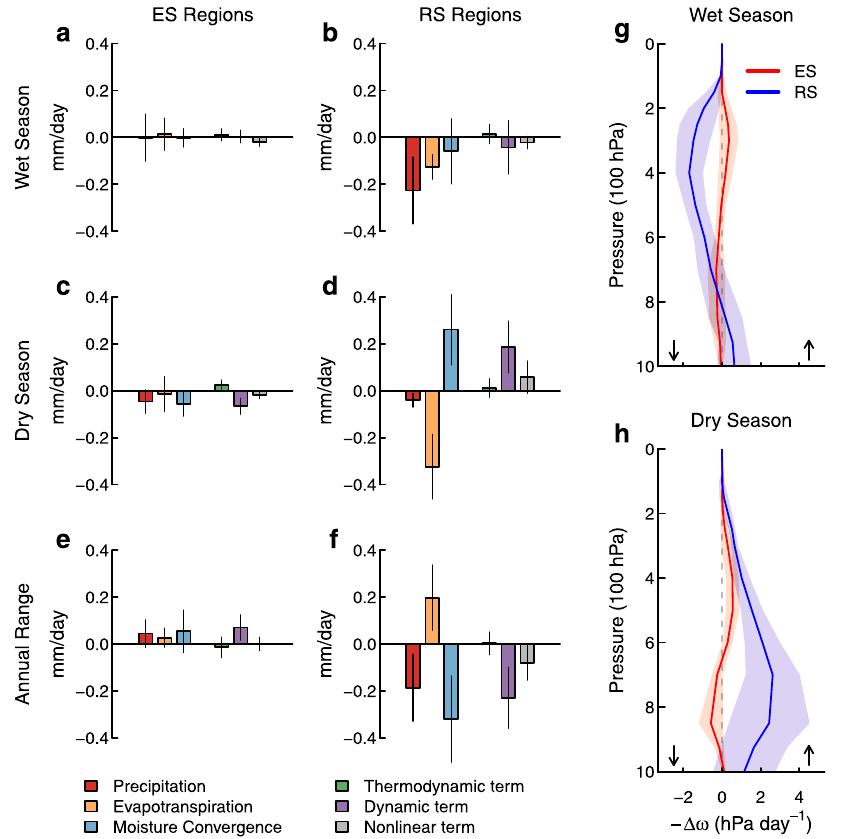
Fig. 5 | Mechanismsofthe soil moisture effectsonwater availability inthe wet and dry seasons. a – f Soil moisture (SM) effects on changes in precipitation, eva- potranspiration, moisture convergence, and the thermodynamic, dynamic, and nonlinear terms of moisture convergence between 1980 – 2000 and 2080 – 2100 in enhanced seasonality (ES) regions and reduced seasonality (RS) regions shown in